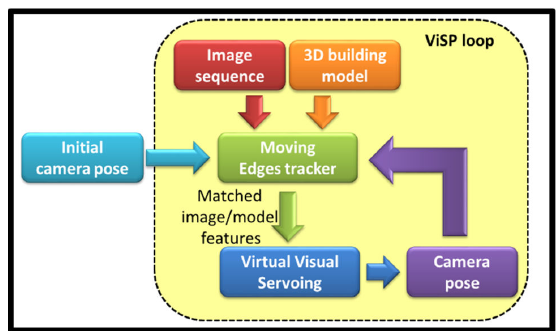
Figure 1. ViSP’s pose estimation workflow.